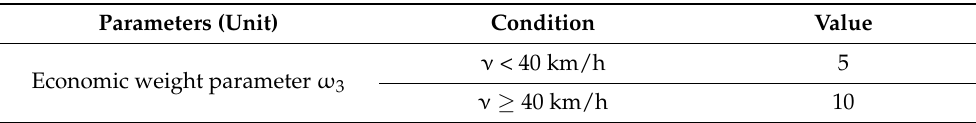
Table 5. Economic weight parameters of MPC2.